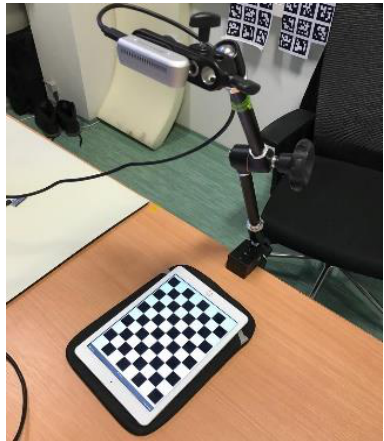
( f ) Figure 8. The black lines depict step boundaries; when the tag moves across this line, a sudden change in the detected tag orientation is observed. Observations for ( a ) Roll; ( b ) Pitch; ( c ) Yaw; ( d ) X; ( e ) Y; ( f ) Z. 5. Recalibration with a Liquid- C rystal Display The observations from the benchmark process mentioned in Table 3 justified that the standard calibration process yielded a set of parameters that left a lot of instability in the Aruco tag detection and the estimation of its pose. Upon observing the fact that the benchmark results were different for